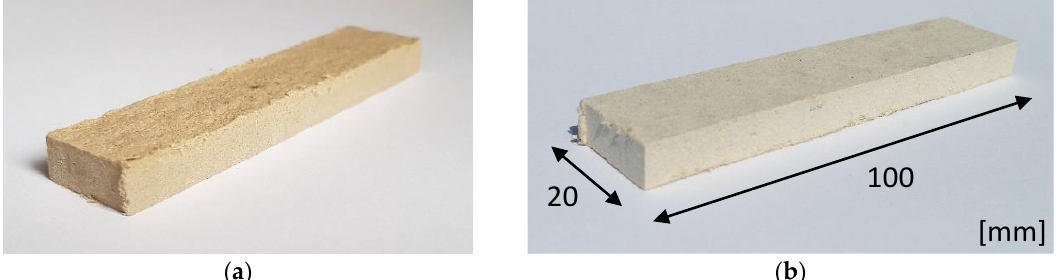
Figure 6. Exemplary specimens of fiber cement boards belonging to ( a ) series C air-dry and ( b ) series C stored in water for 24 h.